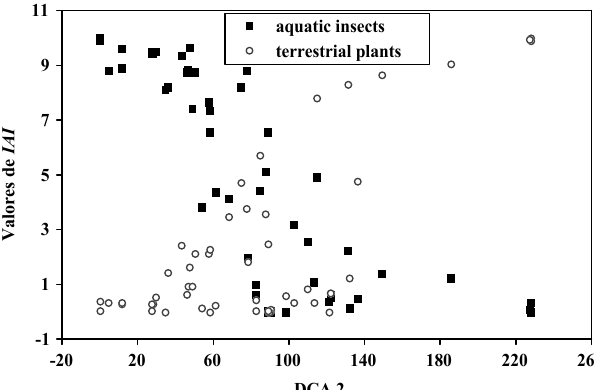
Fig. 4 . Relationship between square-root transformed IAi values for fish, algae and detritus and DCA axis 1.